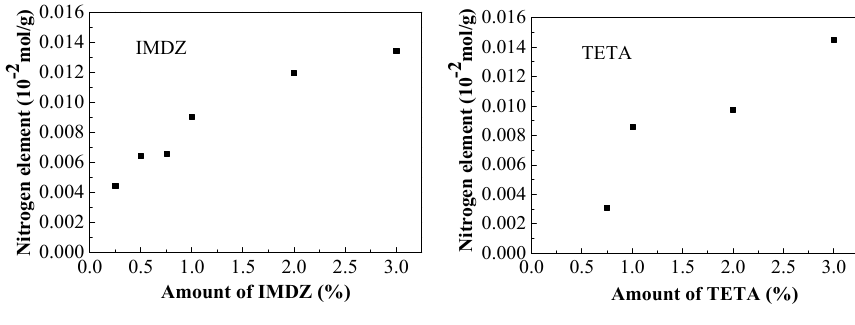
Figure 11. Nitrogen’s content.